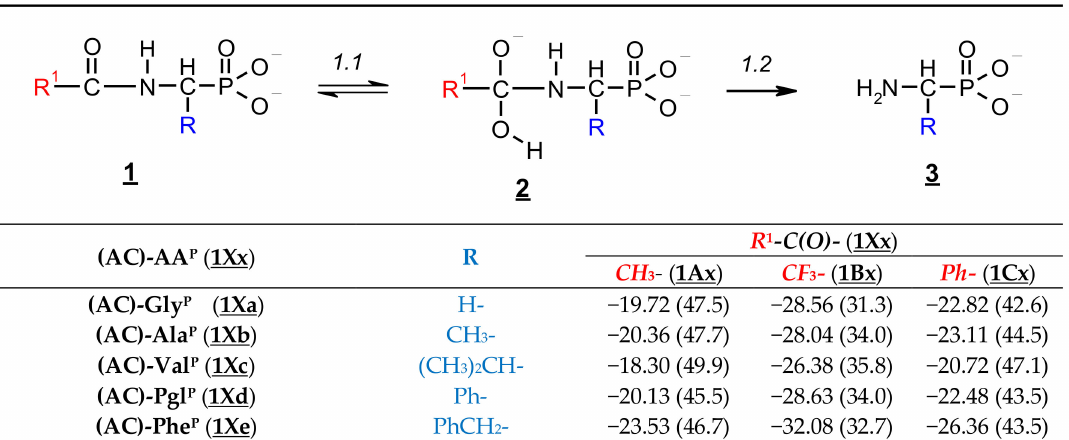
Table 9. Total Gibbs free energies ∆ G 298 ( 1.1 ) + ∆ G 298 ( 1.2 ) for the overall deacylation process in